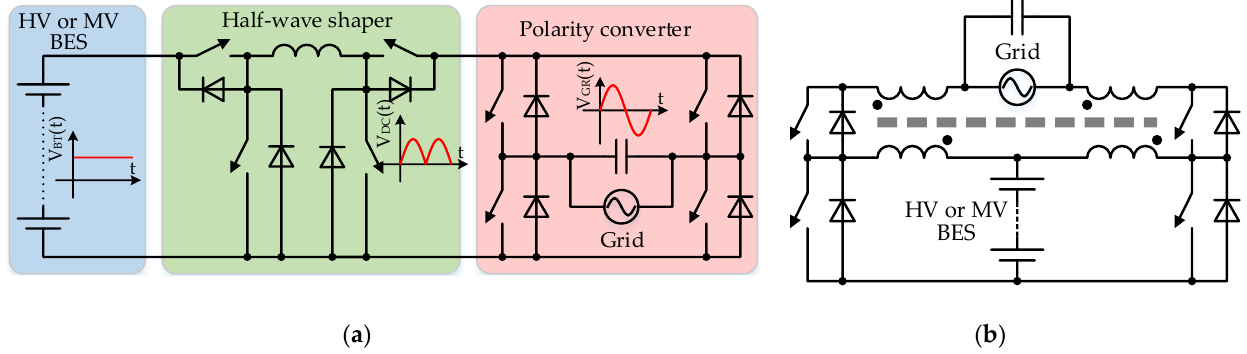
Figure 26. Examples of single-phase unfolders: ( a ) buck-boost converter with unfolding H-bridge, ( b ) tapped inductor buck-boost converter.